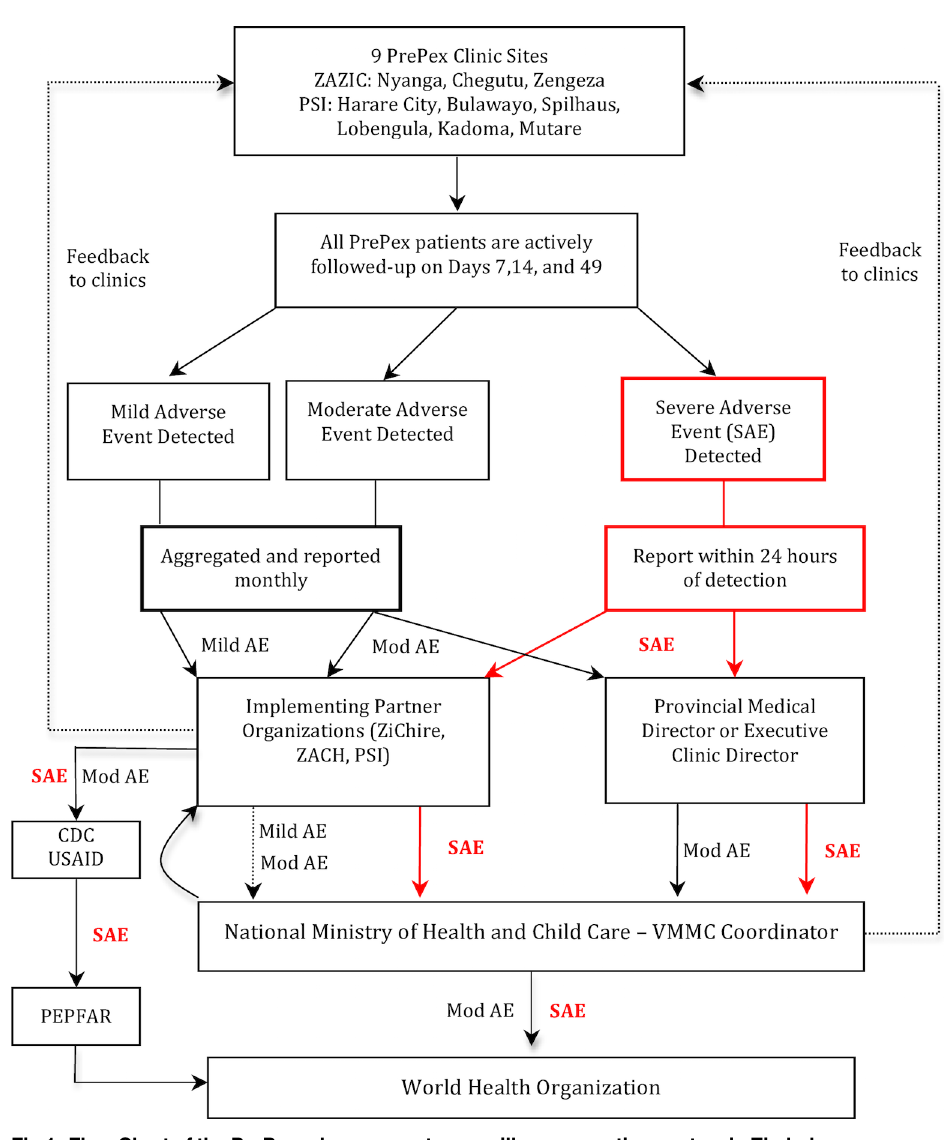
Fig 1. Flow Chart of the PrePex adverseevents surveillance reporting systemin